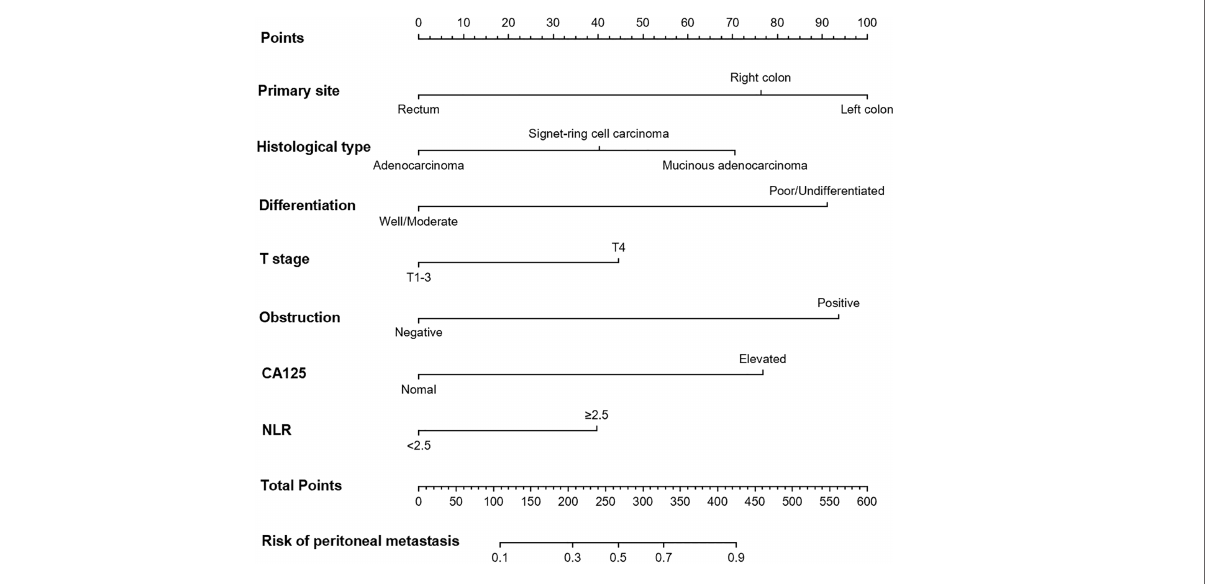
FIGURE 2 | Nomogram for predicting the possibility of occult PM in CRC patients.